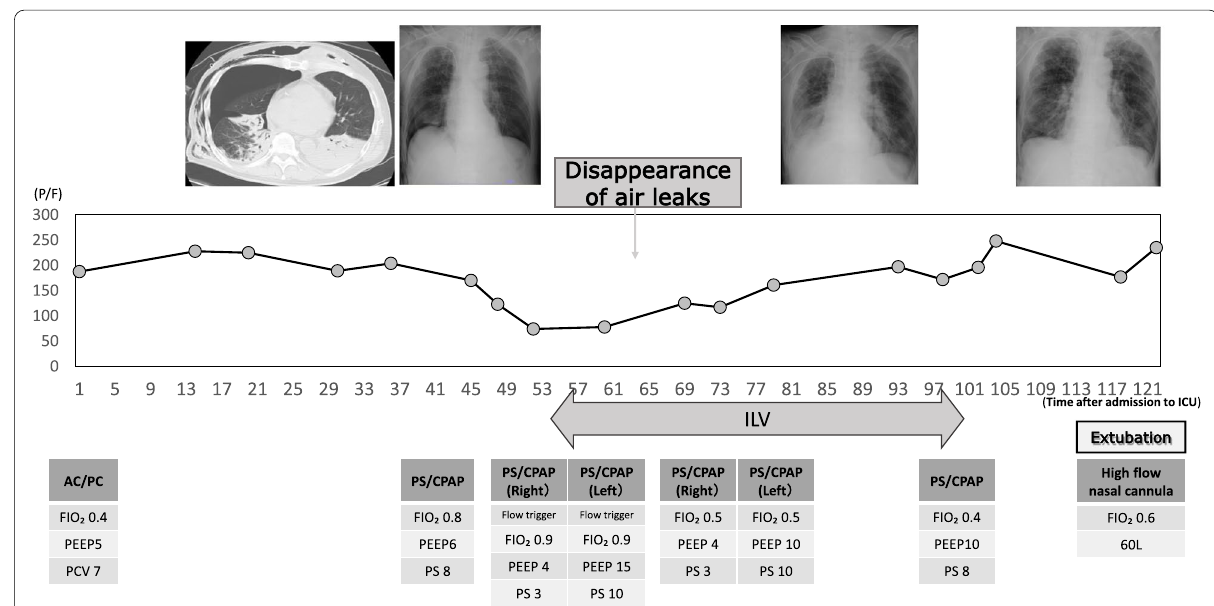
Fig. 2 Course of oxygenation from admission, to the intensive care unit, and to extubation. Worsening of oxygenation observed approximately 45 h after admission. After ILV is started, the oxygenation gradually improves and the patient’s trachea is extubated. A/C, assist control; PC, pressure control; PS/CPAP, pressure support with continuous positive airway